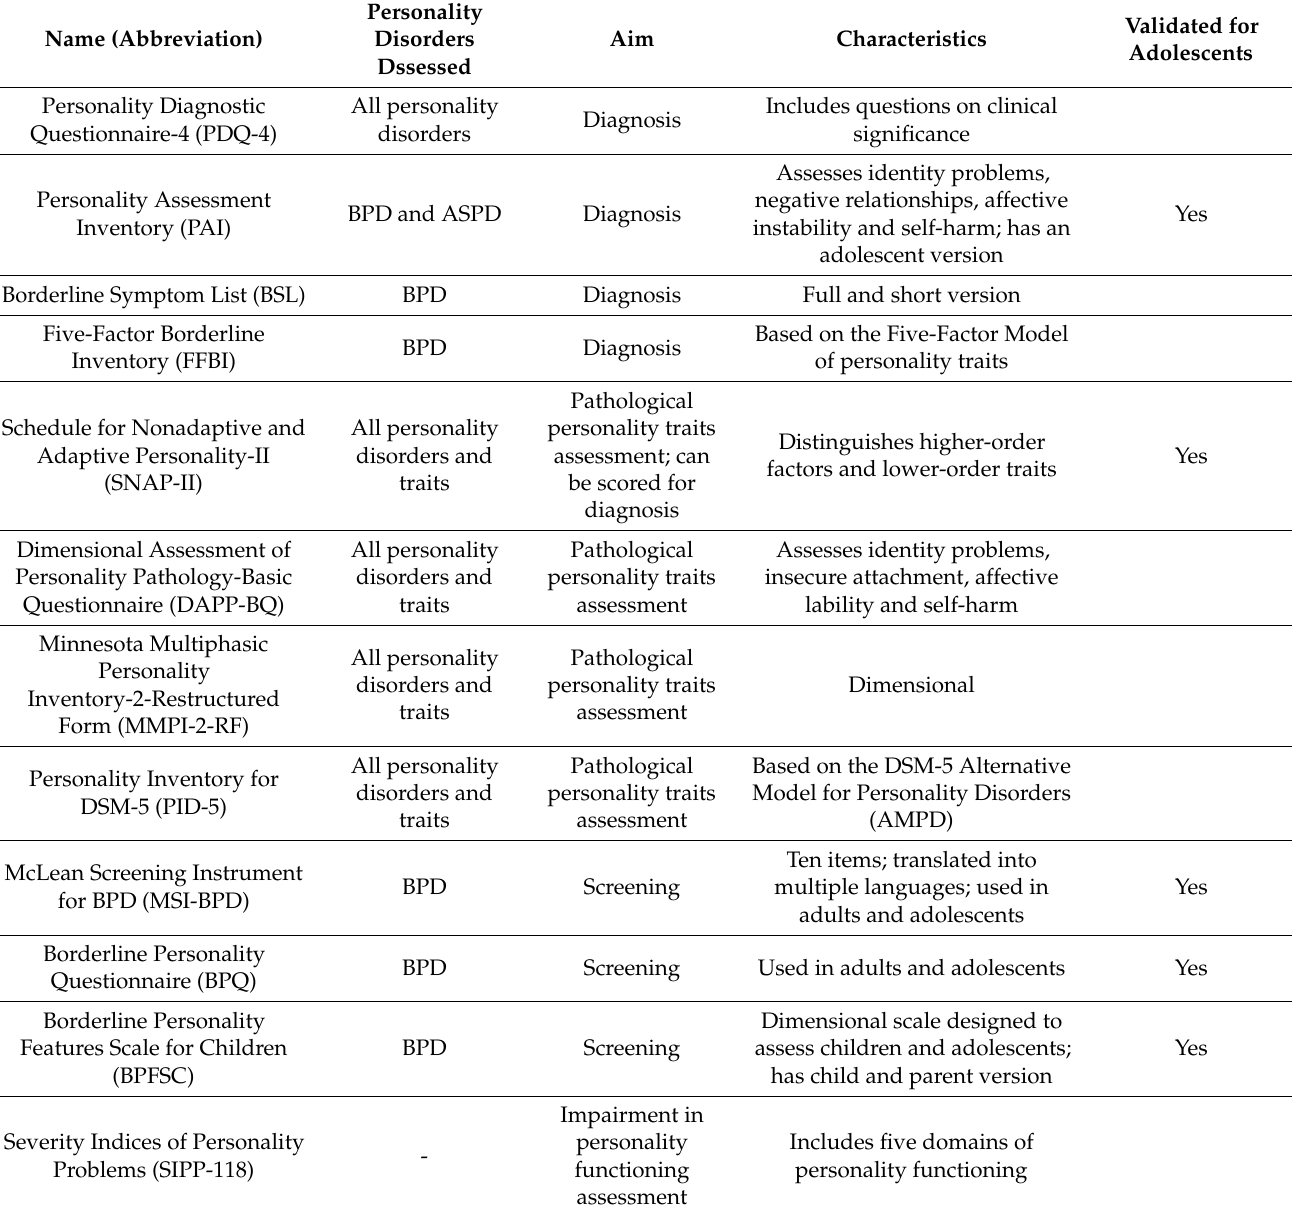
Table 6. Self-report